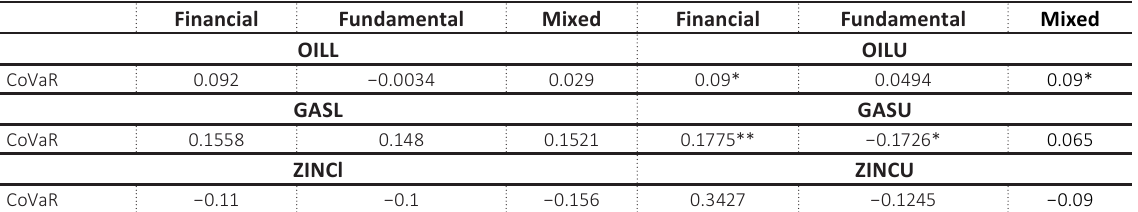
Source: Authors’ calculations.